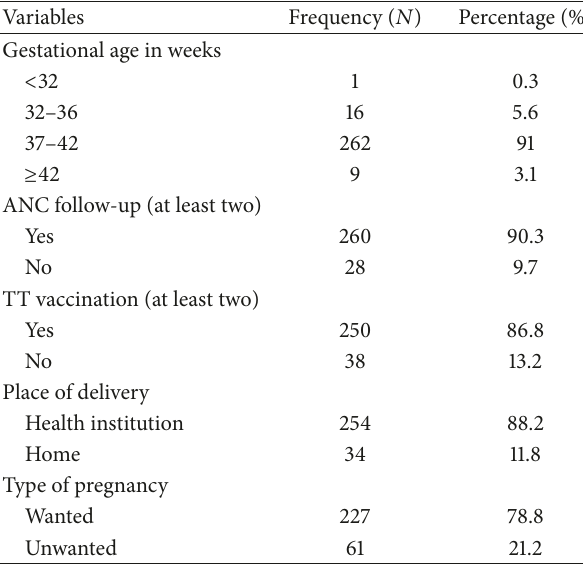
Table 3: Obstetrics history of the mothers in Debre Markos town, Amhara Regional State, North West Ethiopia, September 2016. ( 𝑁 = 288 ).